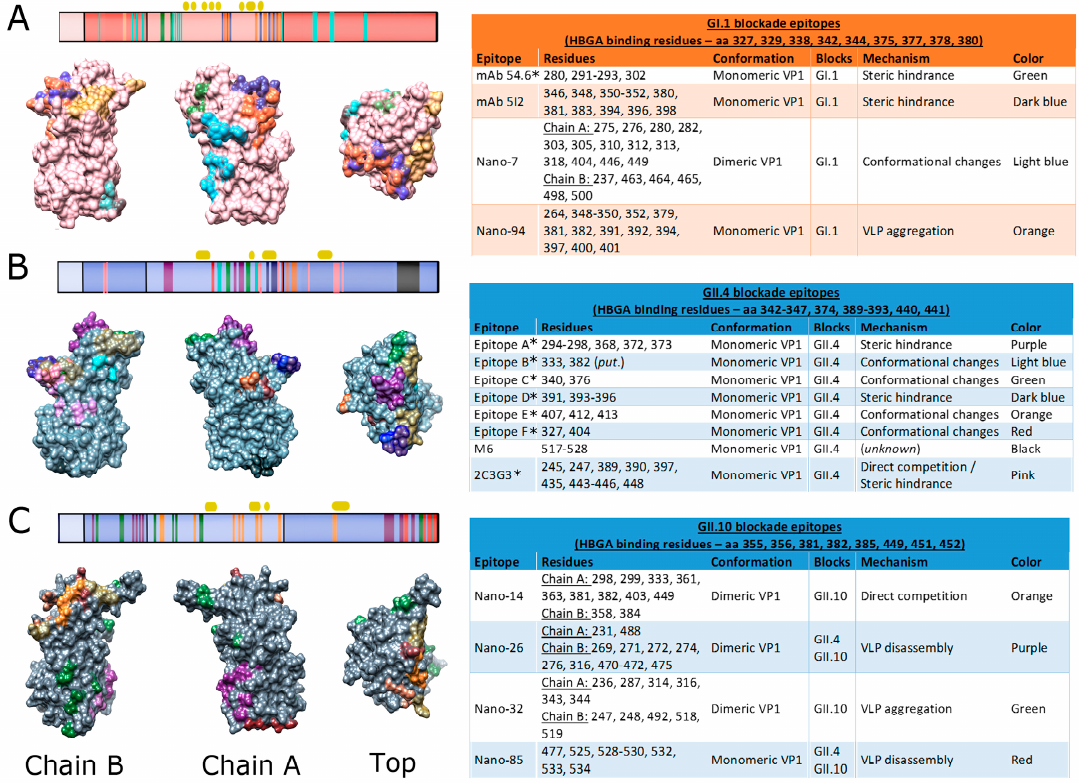
Figure 4. Comparison of HBGA blockade epitopes mapped to ( A ) GI.1, ( B ) GII.4, and ( C ) GII.10 P domains. HBGA binding residues are denoted in gold above the linear representation and the three-dimensional models of HuNoV P domains. Adjacent tables record epitope specificities and coloring that corresponds to the positions of the amino acids on both the linear and three-dimensional diagrams. Antibodies marked with an asterisk (*) do not have an antibody / virus structure associated with their epitope definition. ChimeraX was used to model amino acid binding sites (GI.1 PDB 2ZL6, GII.4 PDB 2OBS, GII.10 PDB